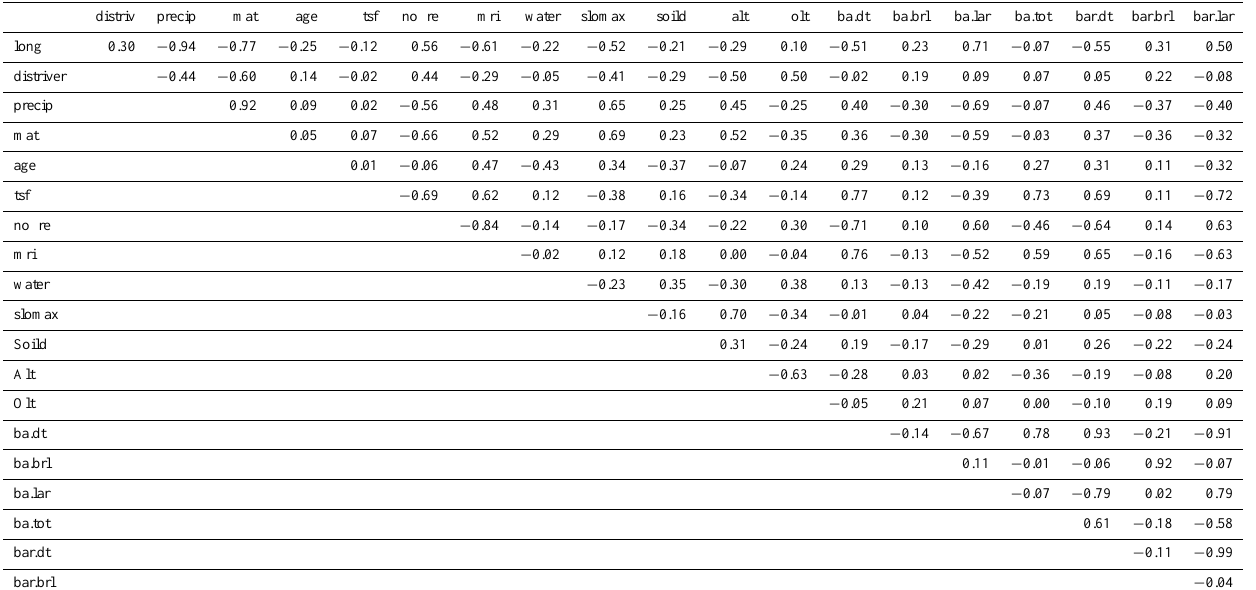
Table 3. Correlation matrix of stand-level predictors and compositional attributes. Long=longitude, distriver=distance to river, pre- cip=precipitation, mat=Mean annual temperature, age=stand age, tsf=time-since-fire, nofire=number of fires during stand development, mri=mean fire return interval calculated as “age/(1+nofire)”, water=ordinal water index from 1 very dry to 5 very wet, slomax=maximum slope, soild=depth of soil until bed rock, alt=active-layer depth, olt=organic layer depth, ba.dt=basal area of dark taiga species ( Picea , Abies , Pinus sibirica ), ba.brl=basal area of broadleaved species (Betula, Populus, Alnus), ba.lar=basal area of Larix , ba.tot=total basal area, bar.dt=percentage basal area of dark taiga species, bar.brl=percentage basal area of broadleaved species, bar.lar=percentage basal area of Larix